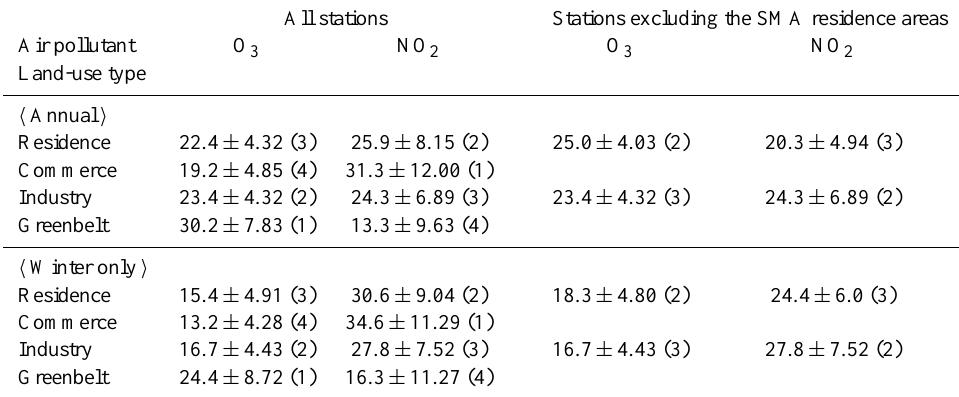
Table 10. Climatological average value of O 3 (ppb) and NO 2 (ppb) over South Korea during 2002–2013 in terms of the MEK four land-use types (residence, commerce, industry and greenbelt) over the 283 total stations and the 209 stations excluding the 74 SMA residence areas, respectively. The spatial variation in the pollutant concentrations for the individual type is presented with the standard deviation of ± values. The number in the parentheses indicates the ranking of each pollutant, based on concentration value over the type. All stations Stations excluding the SMA residence areas Air pollutant O 3 NO 2 Land-use